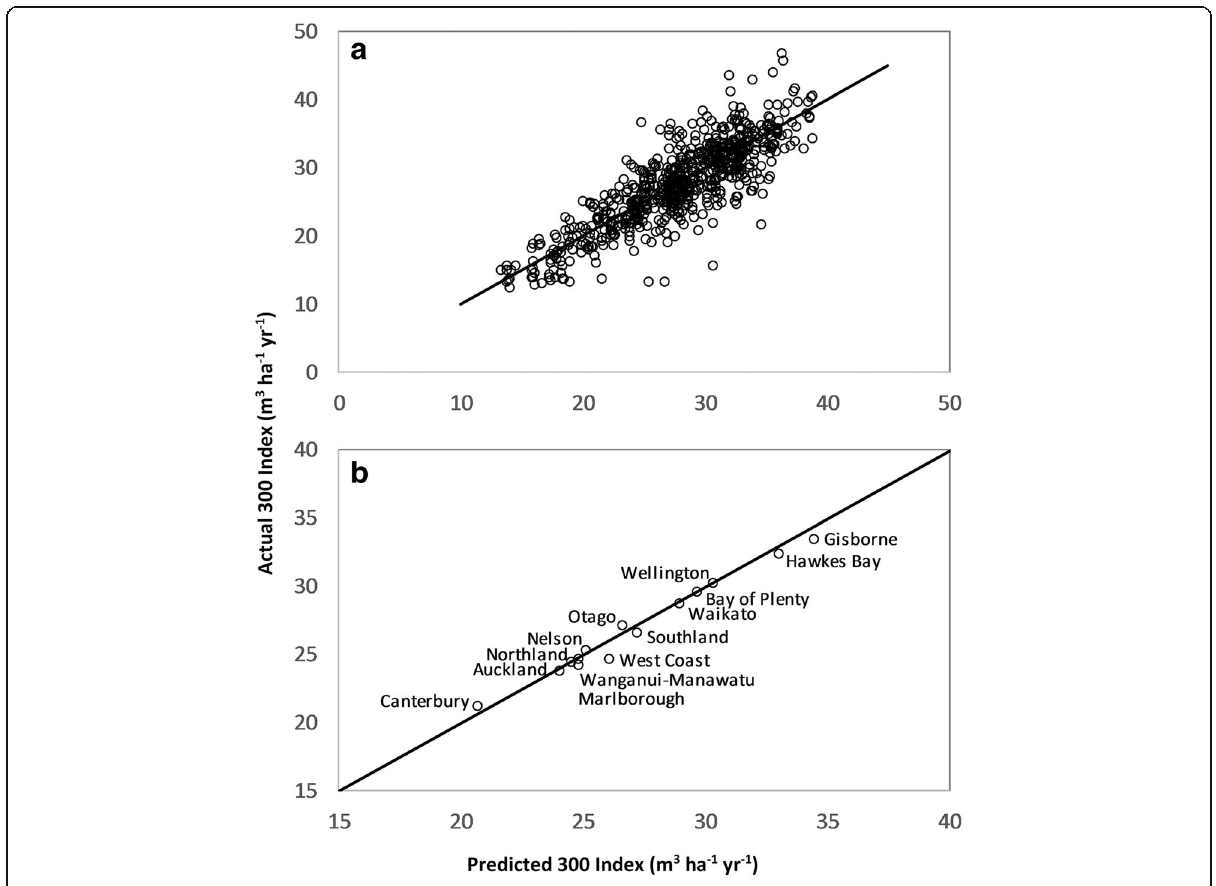
Fig. 3 Title: Actual versus predicted 300 Index for the validation dataset. Actual versus predicted 300 Index for the validation dataset for ( a ) individual plots and ( b ) averages of New Zealand local authority regions. Lines show 1:1